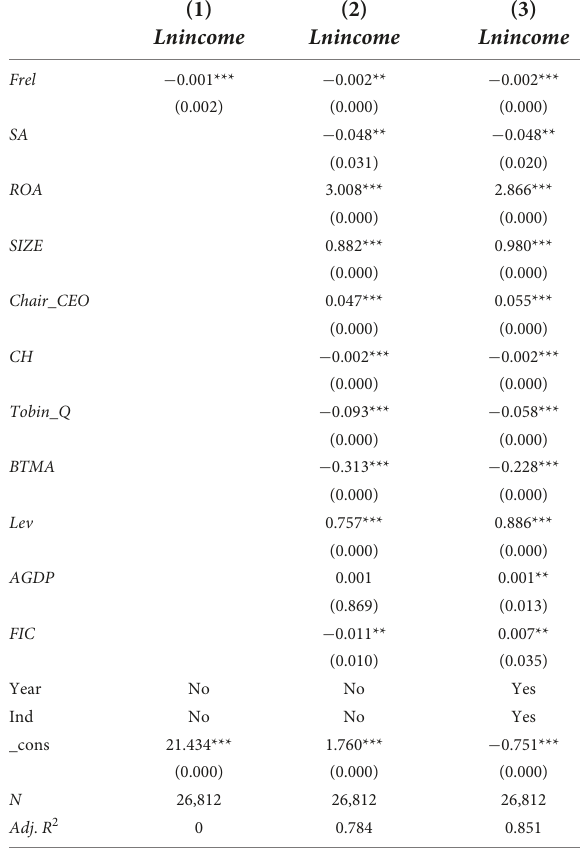
TABLE 5 Regression results when using the extreme climate